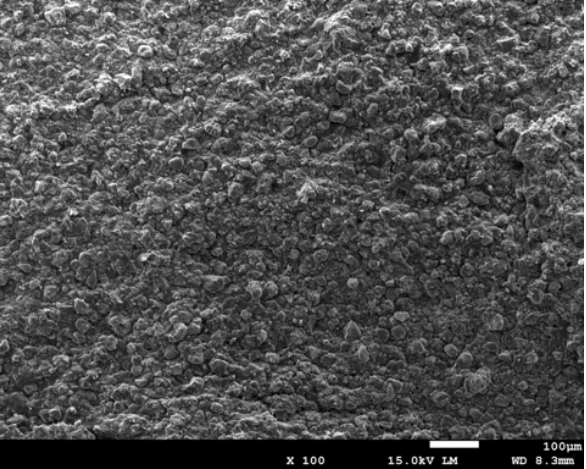
Figure 9: The microstructure of the MDF cements.